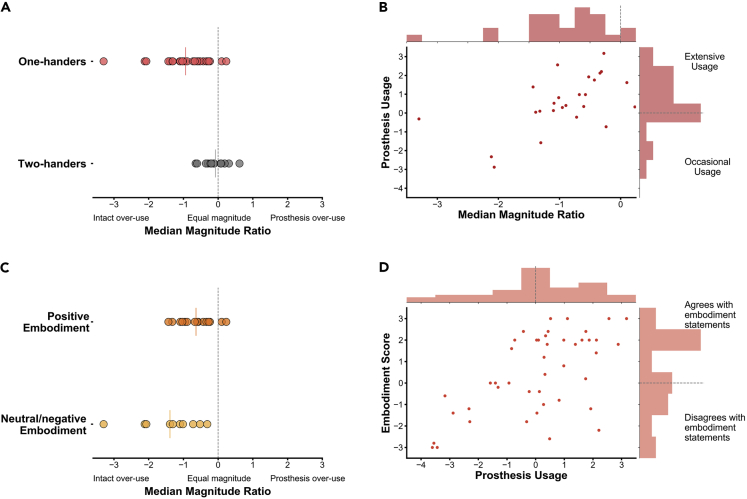
Gesticulation Behavior, Prosthesis Use, and Embodiment(A–C) The median magnitude ratio (MMR) reflects how much each arm contributes to the overall size of gesture movements performed during the task. (A) MMR values across groups; two-handers performed relatively equal size arm movements when gesturing, whereas one-handers were significantly lateralized toward their intact arm (U = 47, p < 0.001). (B) Increased daily prosthesis use (measured by questionnaires) associated with increased incorporation of the prosthesis into gestures (measured by MMR) (rho(23) = 0.55, p = 0.005). (C and D) Embodiment scores reflect individuals' mean response to five subjective embodiment statements. (C) MMR values across individuals who responded positively versus neutral/negatively to prosthesis embodiment statements (for example, “it seems like the prosthesis is my hand,” “it seems like the prosthesis is part of my body”). Individuals who positively embody their prosthesis show increased incorporation of their prosthesis into gestures (Mann-Whitney U = 35, p = 0.03).(D) Greater prosthesis use is associated with greater perceived prosthesis embodiment (rho(42) = 0.53, p < 0.001). In (A and C) solid colored lines indicate the group mean MMR. In (B and D) the dashed lines in the histograms indicate the position of zero.See also Figure S2.